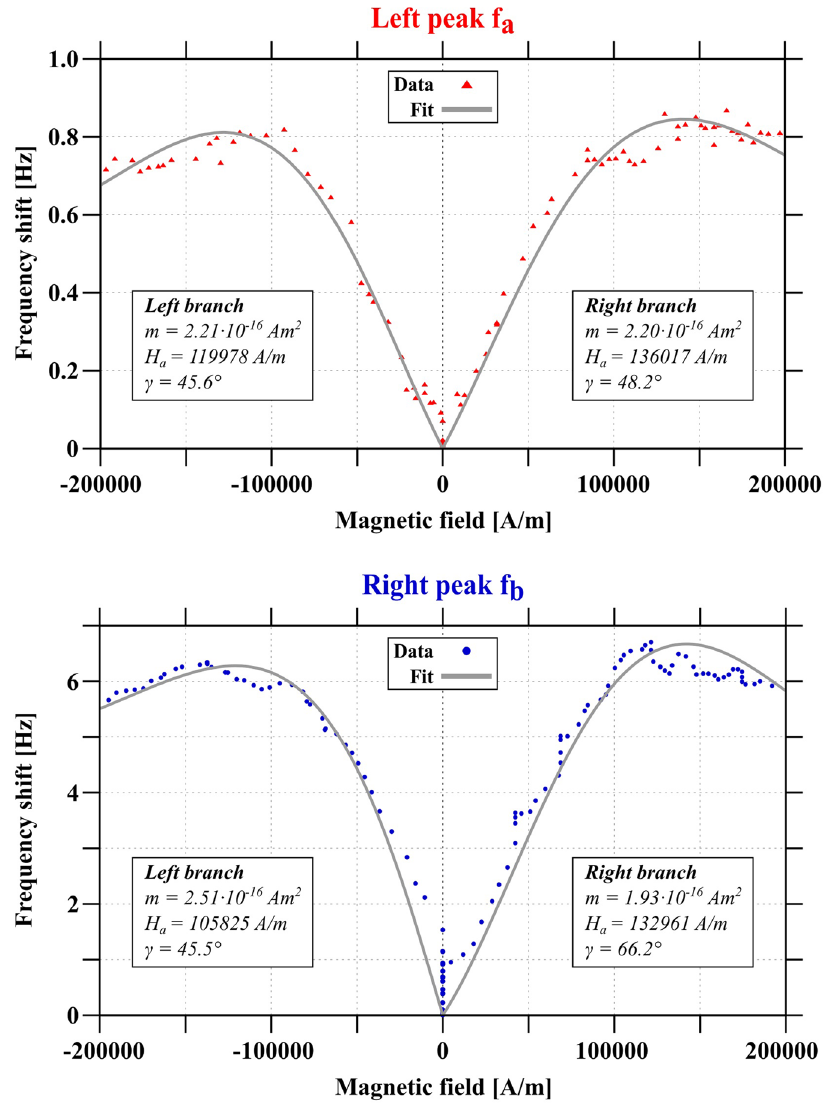
Figure 4. Exemplary frequency shift data for the two resonance peaks of the coupled system fitted with equation (9). Please note that the fit is only valid for small external magnetic fields and was furthermore done for each branch separately. The corresponding parameters are given and show a good agreement. For this figure the unit A/m was chosen to correspond to the theoretical derivation. Experimental data in Fig. 2 is given in T.